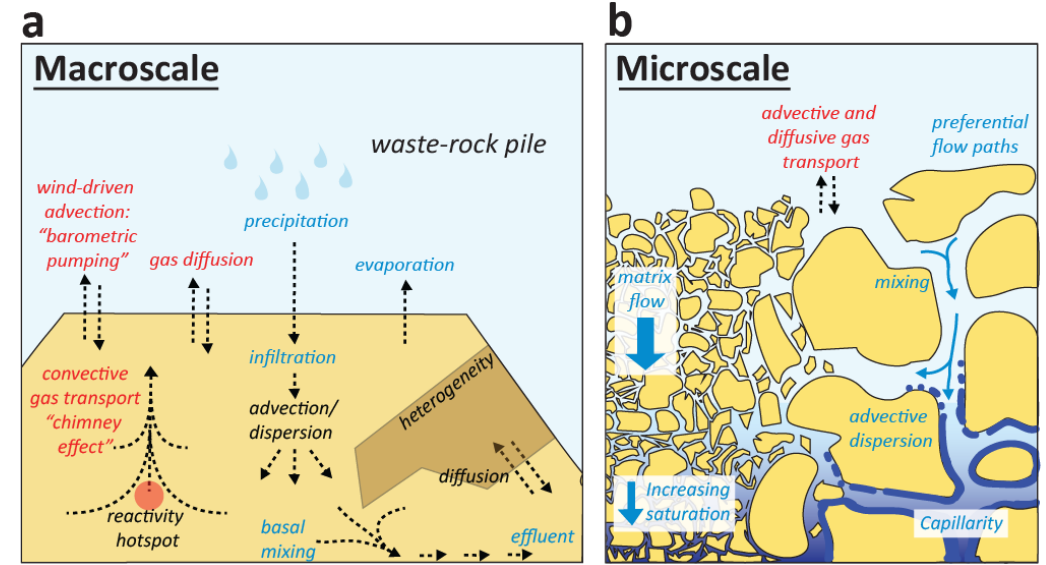
Figure 3. Schematic illustration of relevant aqueous (blue) and gaseous (red) mass transport processes in waste-rock piles, distinguishing between macroscale ( a ) and porescale or microscale ( b ) processes.